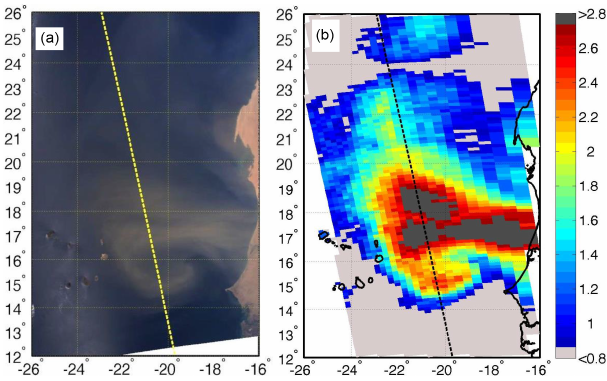
Figure 10. A case of high dust concentrations over the ocean. (a) MODIS RGB image for 9 May 2007 (14:55UTC) off the coast of NE Africa over the Cabo Verde area. (b) OMI Absorp- tion Aerosol Index. The dashed line in both images is the CALIOP